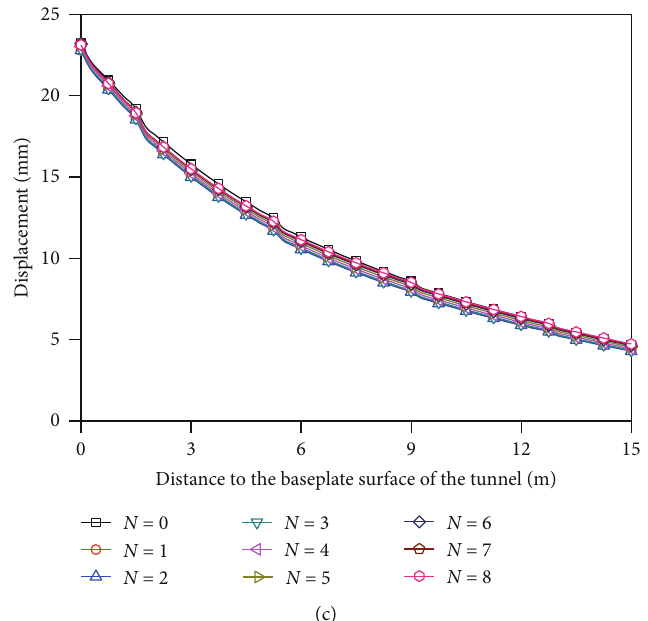
Figure 15: Displacement evolution process of the surrounding rock of the tunnel: (a) tunnel roof, (b) tunnel side wall, and (c) tunnel